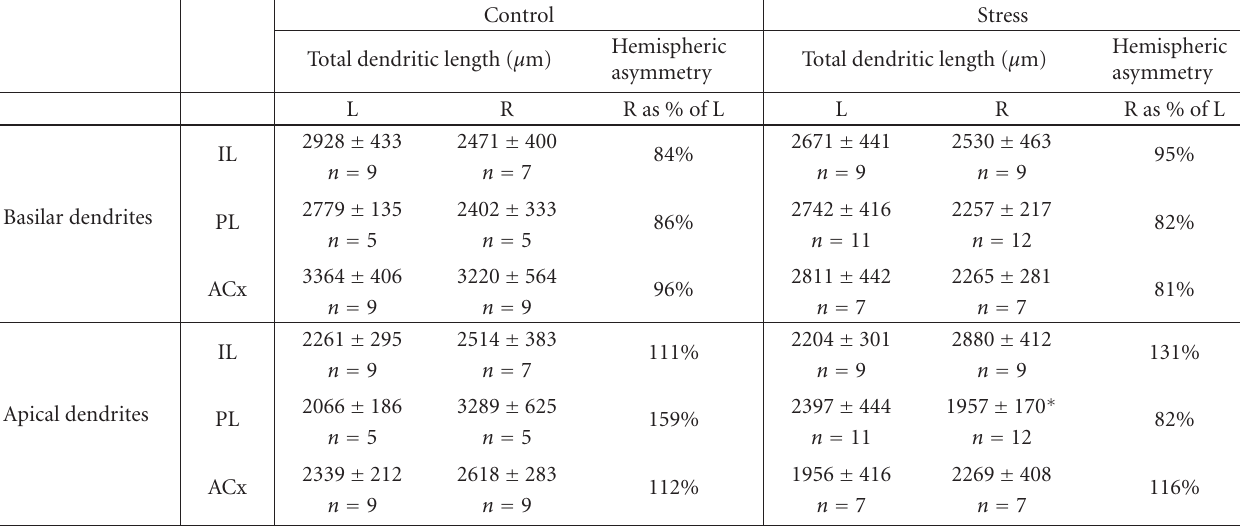
Table 1: Total length (sum of all dendrites, µ m) of basilar and apical dendrites on pyramidal neurons in the three PFC subareas of control and stressed rats. Hemispheric asymmetry refers to the dendritic length in the right compared to the left hemisphere (expressed as percentage). In the PL, chronic restraint stress reduced apical dendritic length exclusively in the right hemisphere (mean ± SEM). n is the number of animals from which data were derived.